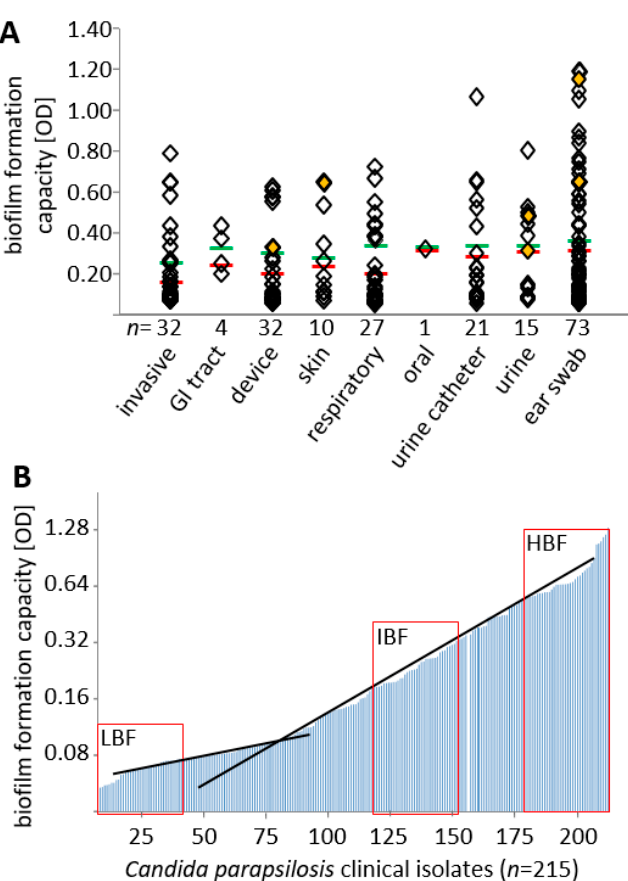
Figure 2. C. parapsilosis collection and selection of isolates for downstream experiments. ( A ) Distribution of collection isolates stratified according to site of isolation and biofilm production on polystyrol. Category “invasive” includes, e.g., blood culture, biopsies, or intraoperative swabs. Orange diamonds: six isolates used in pre-formed biofilm experiments, see text. Red and green lines: mean and two-fold mean values. ( B ) Biofilm formation capacity; isolates sorted by value from low to high. Intersection of black lines: approximated cut-off. Red boxes indicate strain selection of representative low (LBF, left box), intermediate (IBF, middle box) and high (HBF, right box) biofilm formers for subsequent experiments.